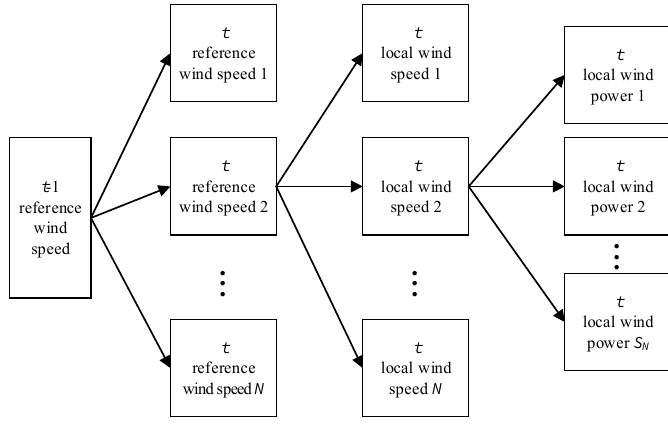
Figure 1. The logic process of modeling wind power.